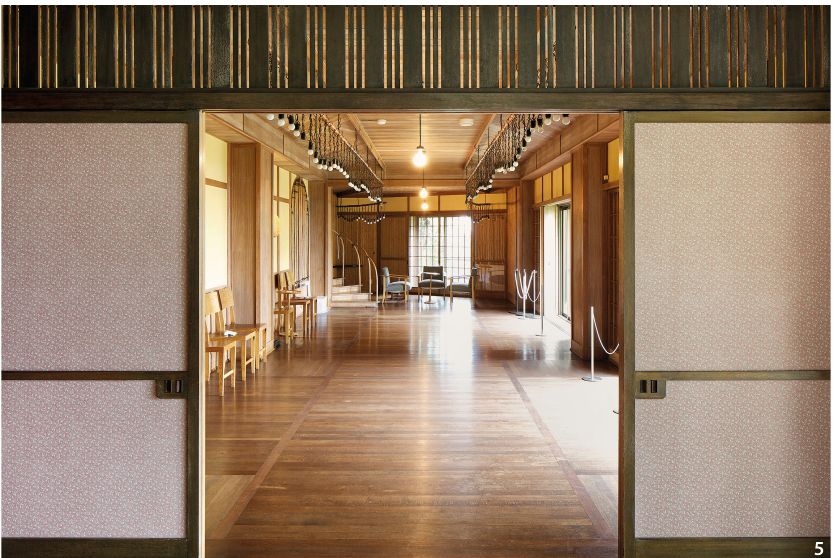
Figure 5 Ping-pong room as seen from the western-style living room (Source: Dave